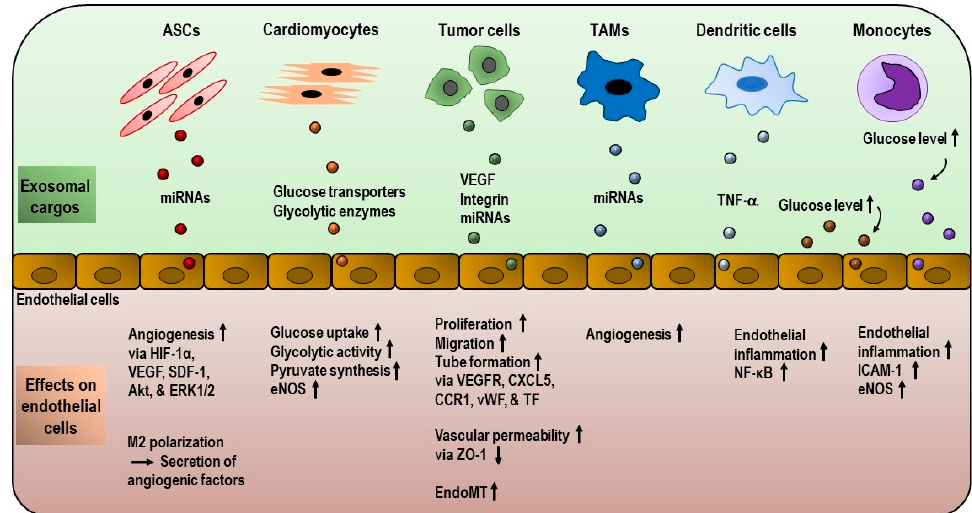
Figure 4. Exosome ‐ mediated remodeling of endothelial gene expression and metabolism. Exo ‐ Figure 4. Exosome-mediated remodeling of endothelial gene expression and metabolism. Exosomes derived from various somes derived from various kinds of cells, including tumor and immune cells, have the ability to kinds of cells, including tumor and immune cells, have the ability to alter the behavior, metabolism and gene expression in alter the behavior, metabolism and gene expression in endothelial cells. ( ↑ : increased; ↓ : de ‐ endothelial cells. ( ↑ : increased; ↓ : creased)